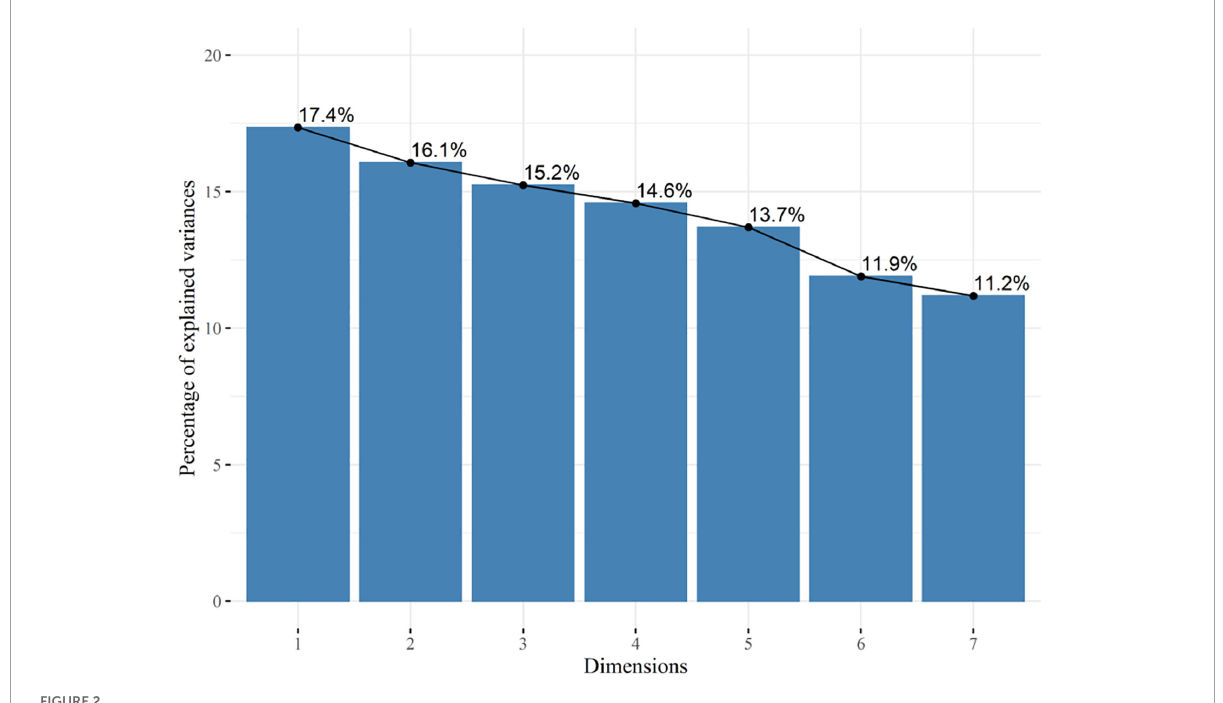
FIGURE2 Principal component analysis (PCA) Ped-ANAM.